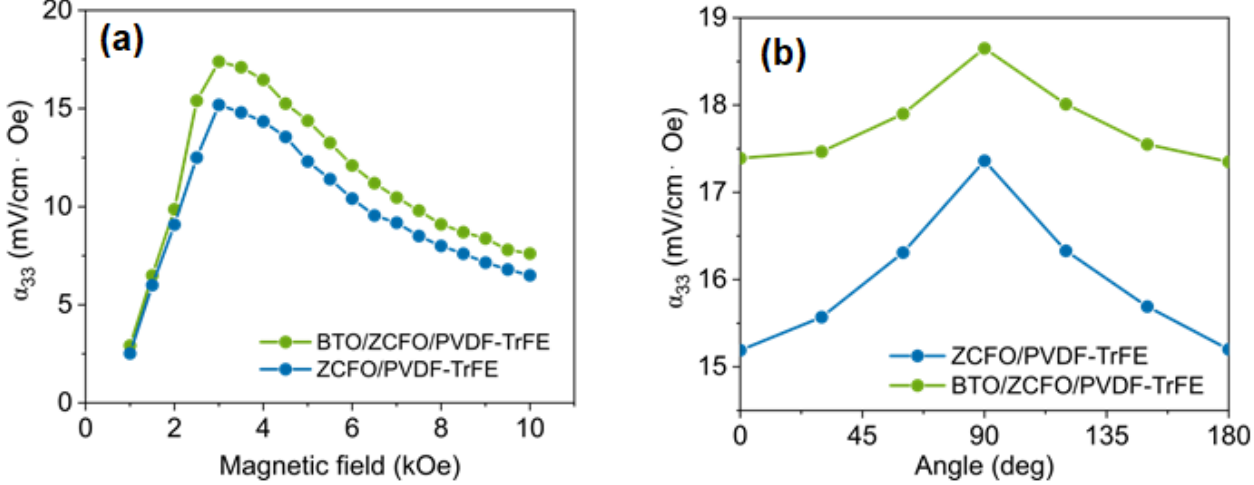
Figure 6. Dependences of ME voltage coefficients ( α ME ) of ZCFO/PVDF-TrFE and BTO/ZCFO/PVDF-TrFE samples on: ( a ) the amplitude H AC of the applied magnetic field at room temperature; and ( b ) the angle between the field direction and the normal to the film plane (room temperature).